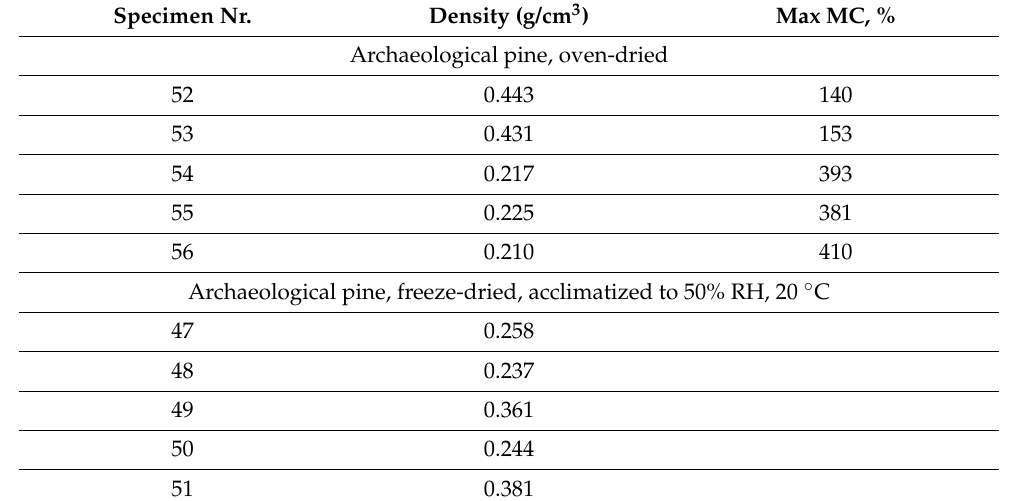
Figure 2. Samples used for wood characterization after oven-drying. Images show variability in samples: ( a ) nr. 52 has a knot (dark spot on upper left corner), 54 shows cross-grained cracking after freeze-drying or oven-drying. ( b ) nr. 53 has orange staining on it transverse section, possibly iron compounds. Additionally, note that the annual rings are not aligned with sample sides. ( c ) nr. 56 shows cross-grained cracking after freeze- or oven-drying. Table 3. Characterization of wood specimens by density and maximum moisture content. For the oven-dried specimens, density is based on oven-dried weight and waterlogged volume. For the specimens acclimatized to 50% RH and 20 ◦ C, the density is based on weight at 50% RH and volume at 50% RH. Specimen